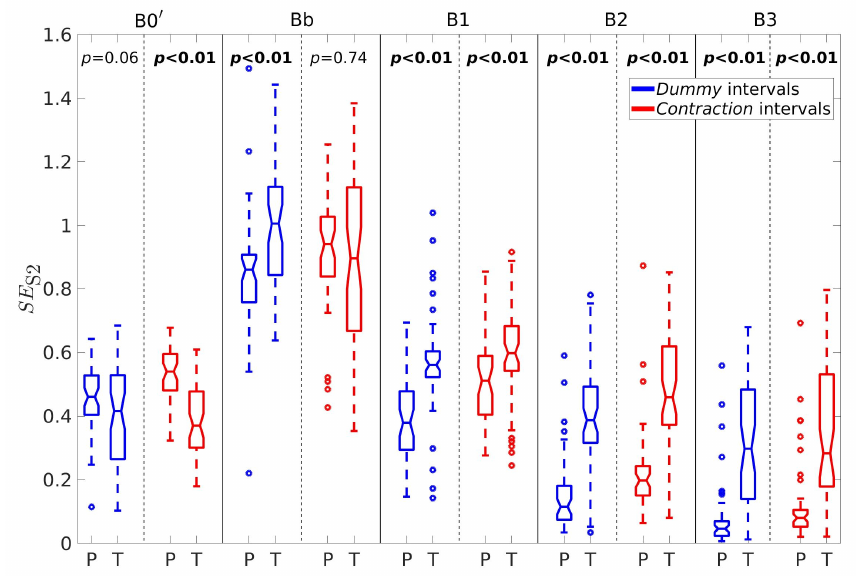
Figure 9. Box plots of sample entropies of the EHG signal S2, SE S2 . P—preterm intervals, T—term intervals.